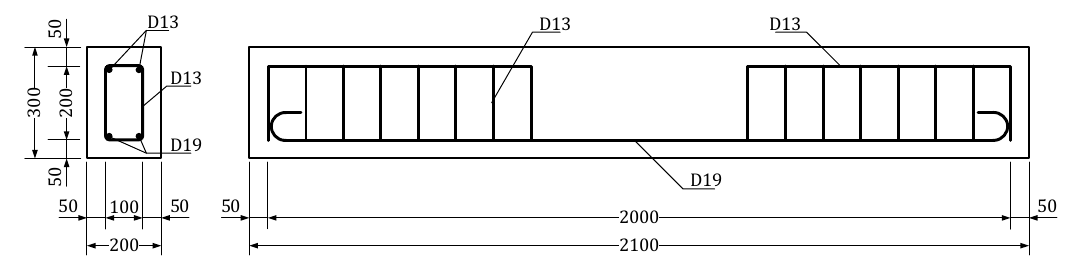
Figure 3. Dimensions and shape of flexural test members.